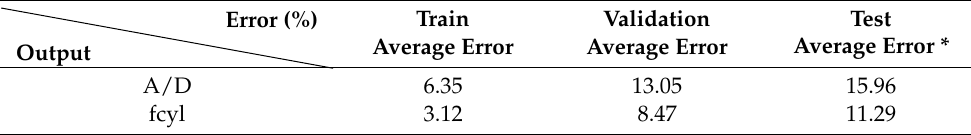
Figure 11. Loss (RMSE) function per epoch. Table 6. Average error rate by data in a learned neural network. Table 6. Average error rate by data in a learned neural